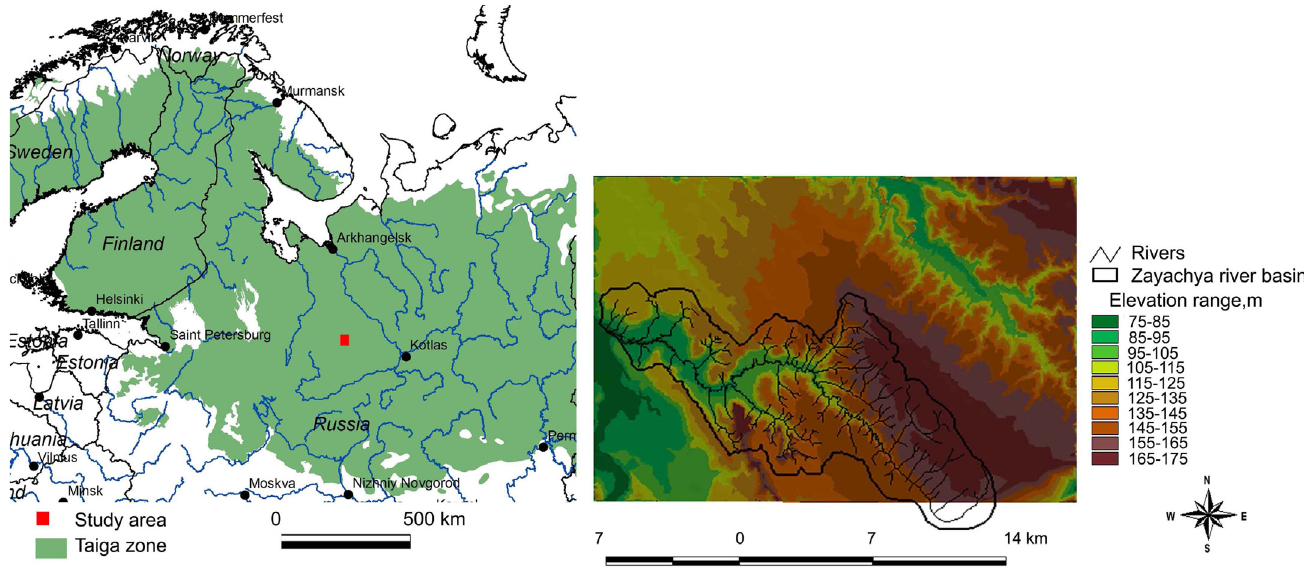
Figure 1: Location (left) and digital elevation model (right) of the study